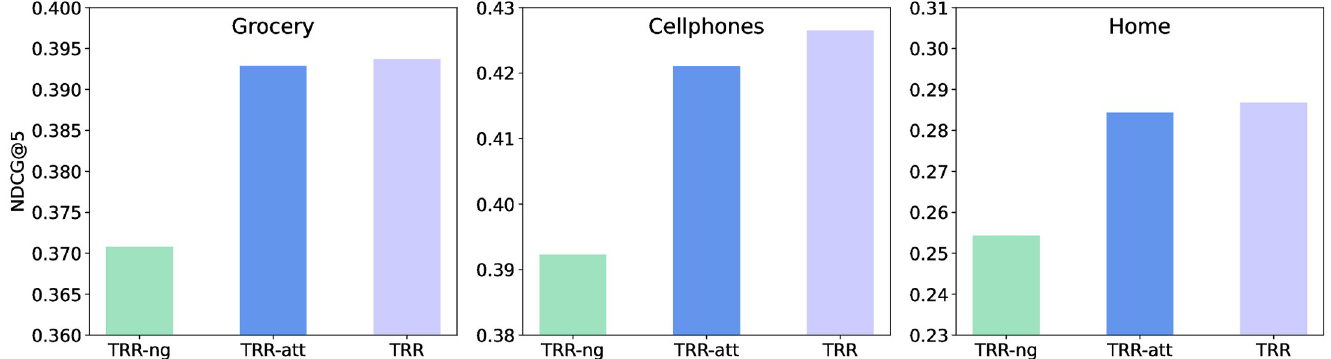
Fig 4. The impact of the gating layer on three datasets